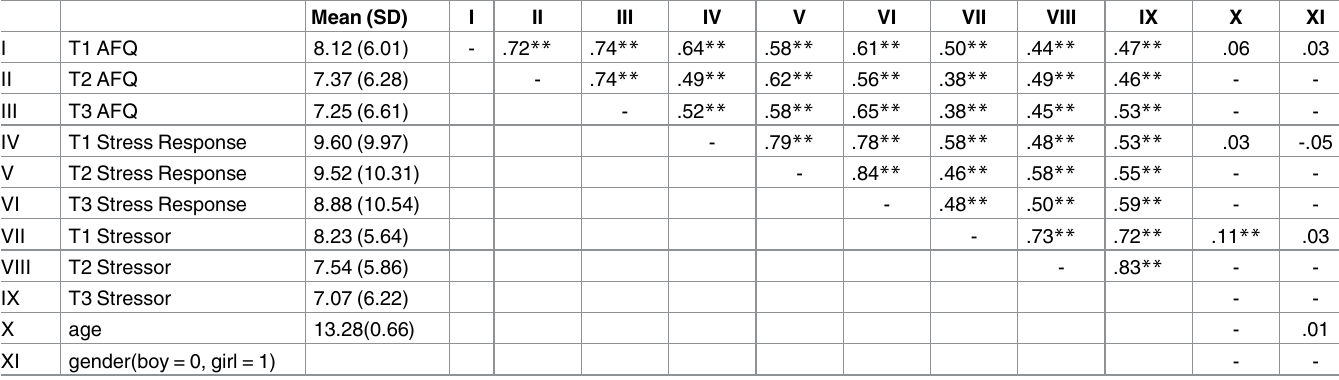
Table 1. Means, Standard Deviations, and Correlations between all